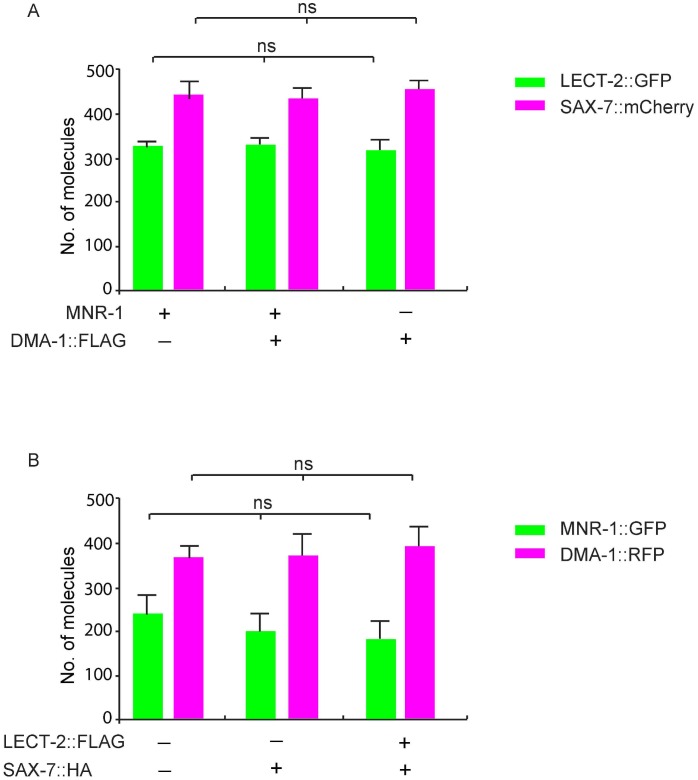
Prey proteins are expressed at similar levels in different groups.(A) C. elegans expressed LECT-2::GFP, SAX-7::mCherry, with or without co-expression of DMA-1::FLAG and MNR-1, were used in SiMPull. Lysates were applied to a chamber coated with anti-GFP or anti-RFP antibody to compare the concentration of LECT-2::GFP and SAX-7﻿::mCherry. 5 different regions of the imaging surface were imaged and quantified. One way ANOVA was used for statistical analysis. ns: not significant. Data are represented as mean ± SEM. (B) Drosophila S2 cells expressed DMA-1::RFP, MNR-1::GFP, with or without co-expression of SAX-7::HA and LECT-2::FLAG, were used in SiMPull. Lysates were applied to a chamber coated with anti-GFP or anti-RFP antibody. 5 different regions of the imaging surface were imaged and quantified. One way ANOVA was used for statistical analysis. ns: not significant. Data are represented as mean ± SEM.